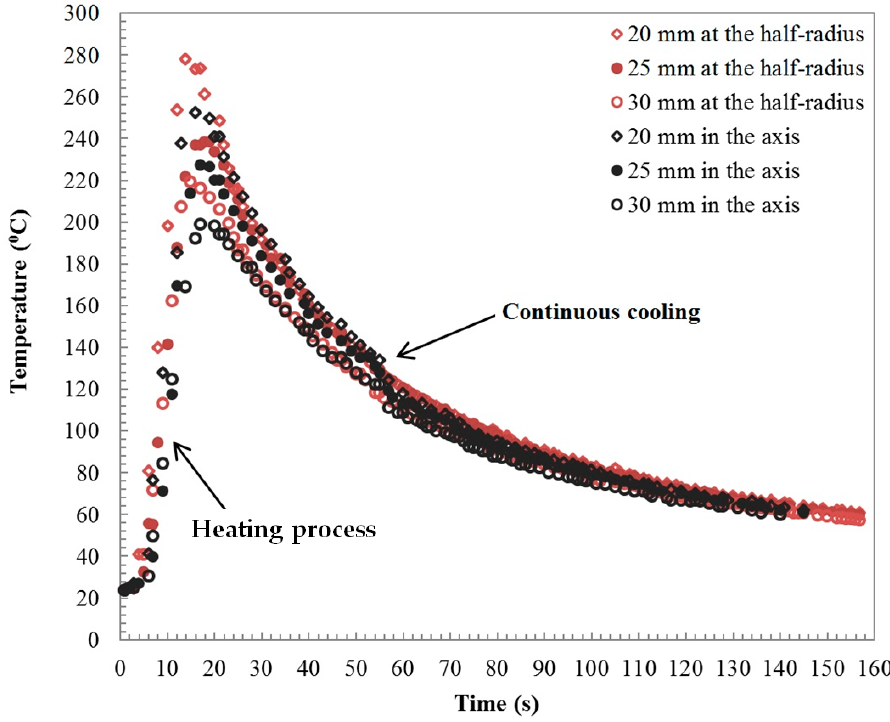
Figure 8. Comparison of time–temperature profiles in the tungsten composite/aluminum alloy friction-welded